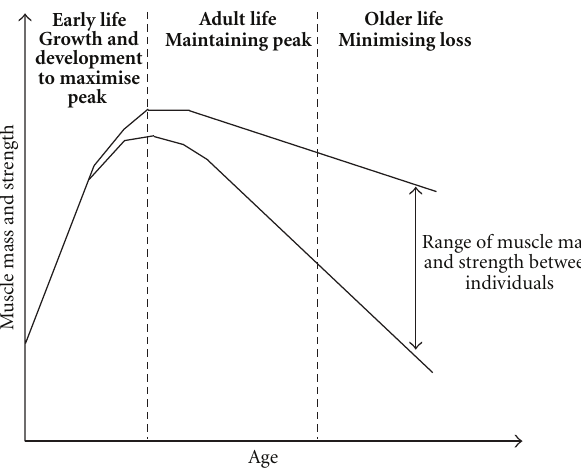
Figure 1: A lifecourse model of sarcopenia (from